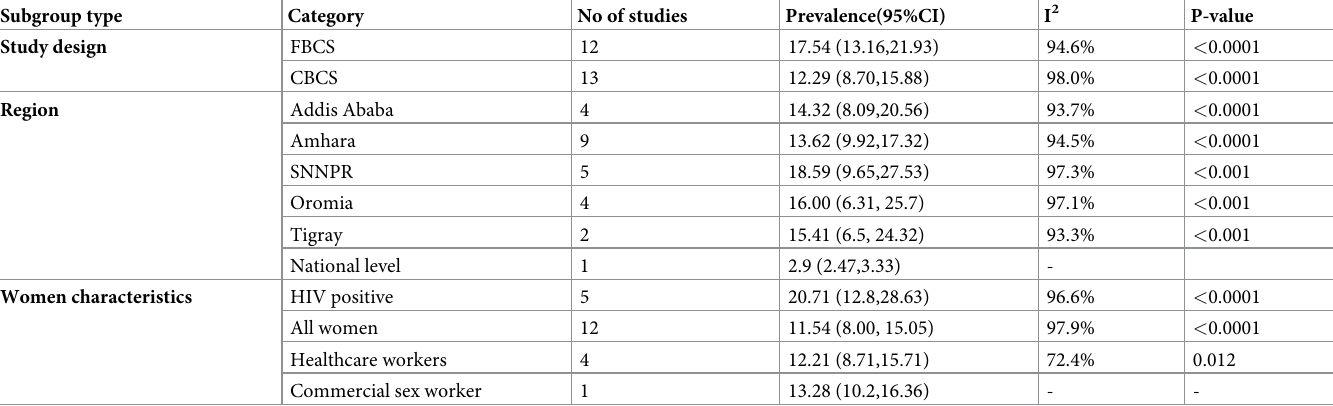
Table 2. Sub-group analysis of cervical cancer screening utilization in Ethiopia: A